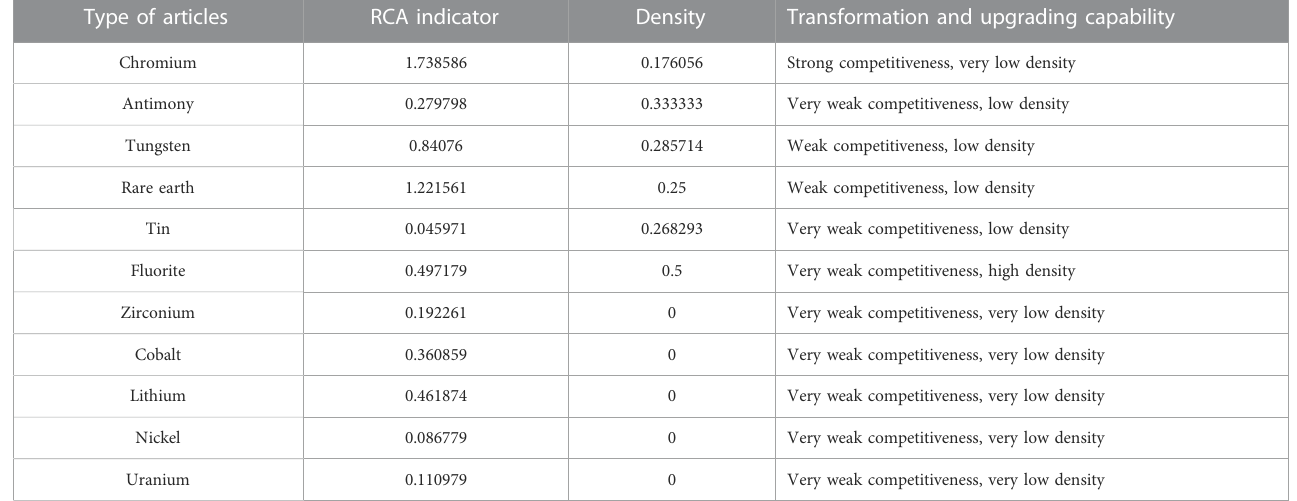
TABLE 3 The analysis form of strategic and critical mineral articles transformation upgrade. Type of